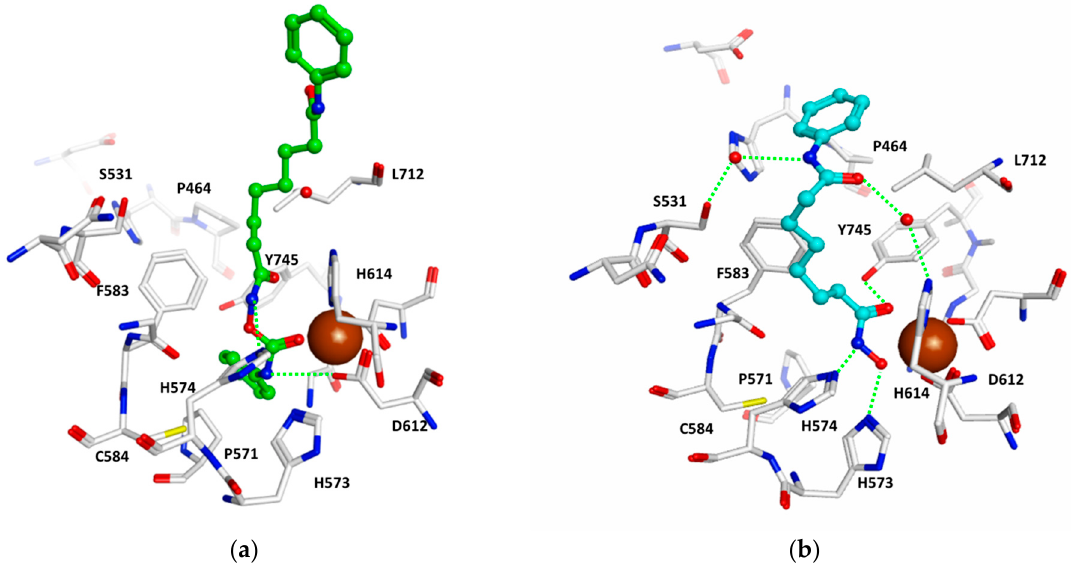
Figure 2. Docking results for HDAC6. ( a ) Interaction of 2d (green) with HDAC6; ( b ) crystal structure of HDAC6 in complex with the inhibitor SAHA (cyan, PDB ID 5GOI). The zinc ion is shown as a brown ball, and hydrogen bonds are drawn as dashed green lines.